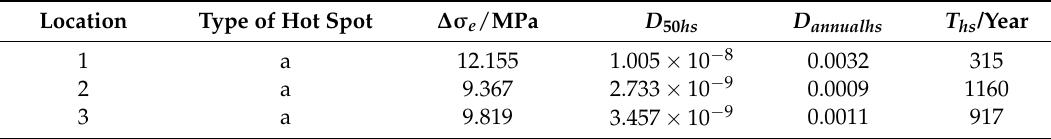
Table 5. Fatigue assessment result based on hot spot stress